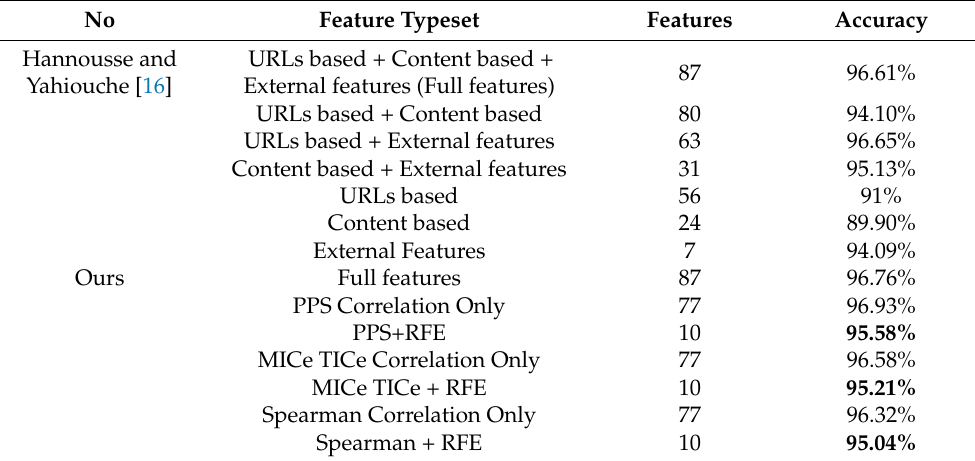
Table 18. The studies feature set and accuracy comparison on Hannousse and Yahiouche